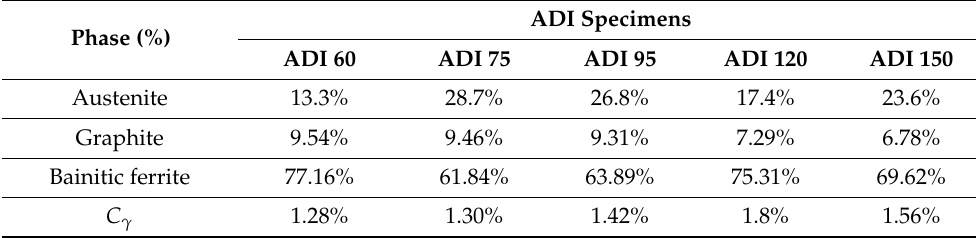
Table 3. Area fractions of different phases in ADI specimens